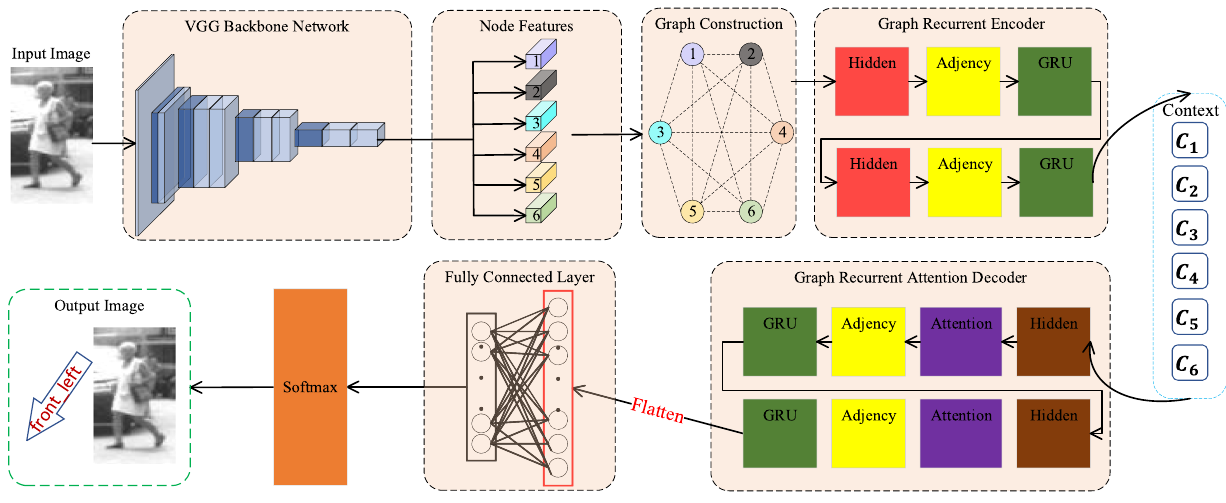
Fig. 2 Whole proposed framework